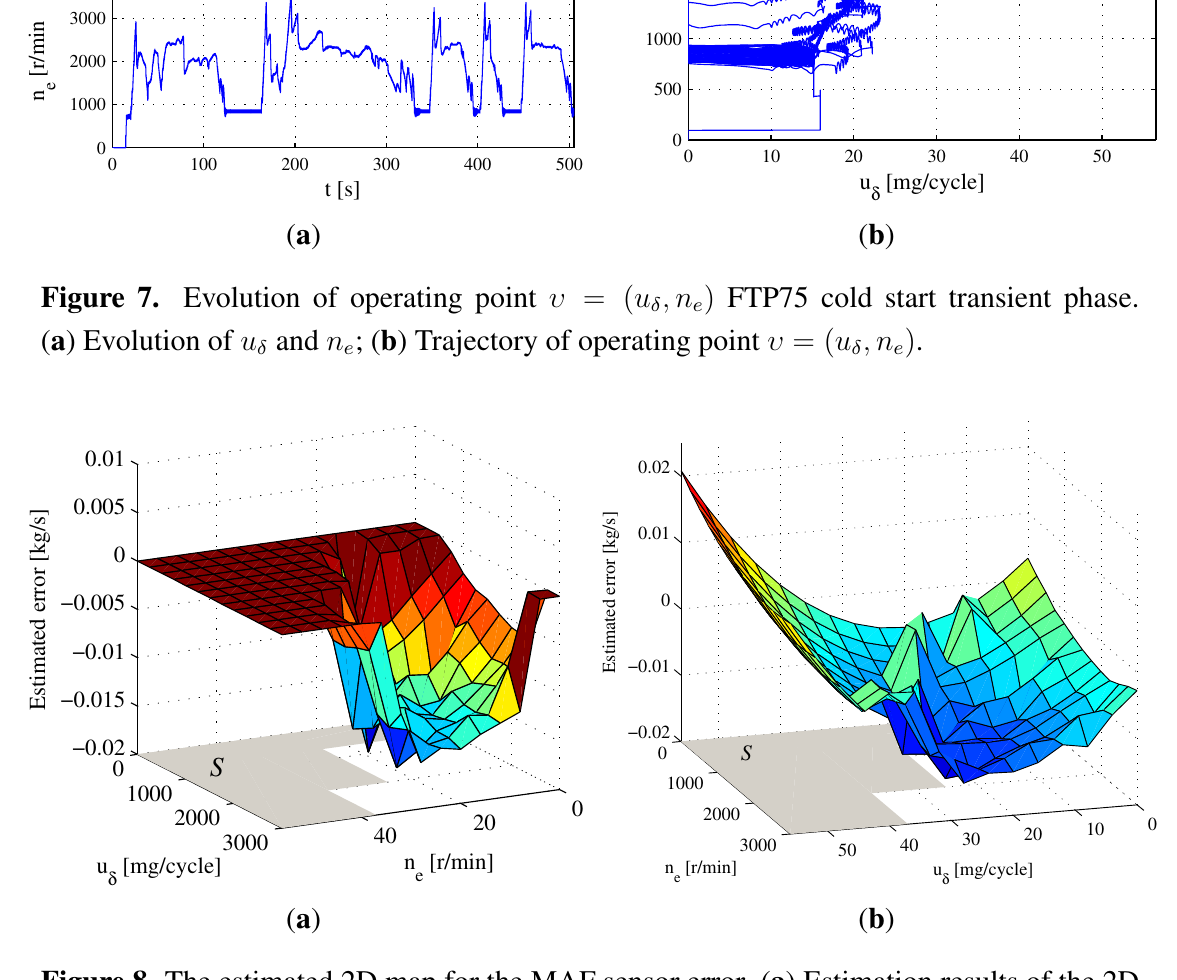
Figure 8. The estimated 2D map for the MAF sensor error. ( a ) Estimation results of the 2D map under FTP75 cold start transient phase; ( b ) Extrapolation results based on the estimated 2D